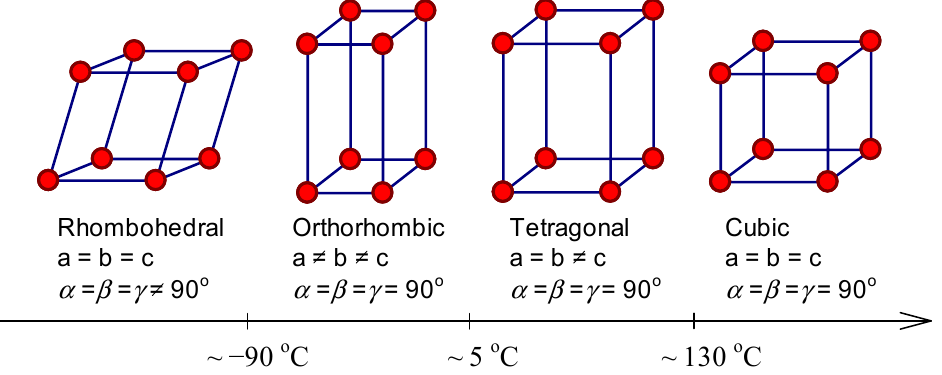
Figure 1. Schematic diagrams of phase transitions for pure BaTiO 3 in the temperature range from − 90 ◦ C to 130 ◦ − 90 °C to 130 °C.